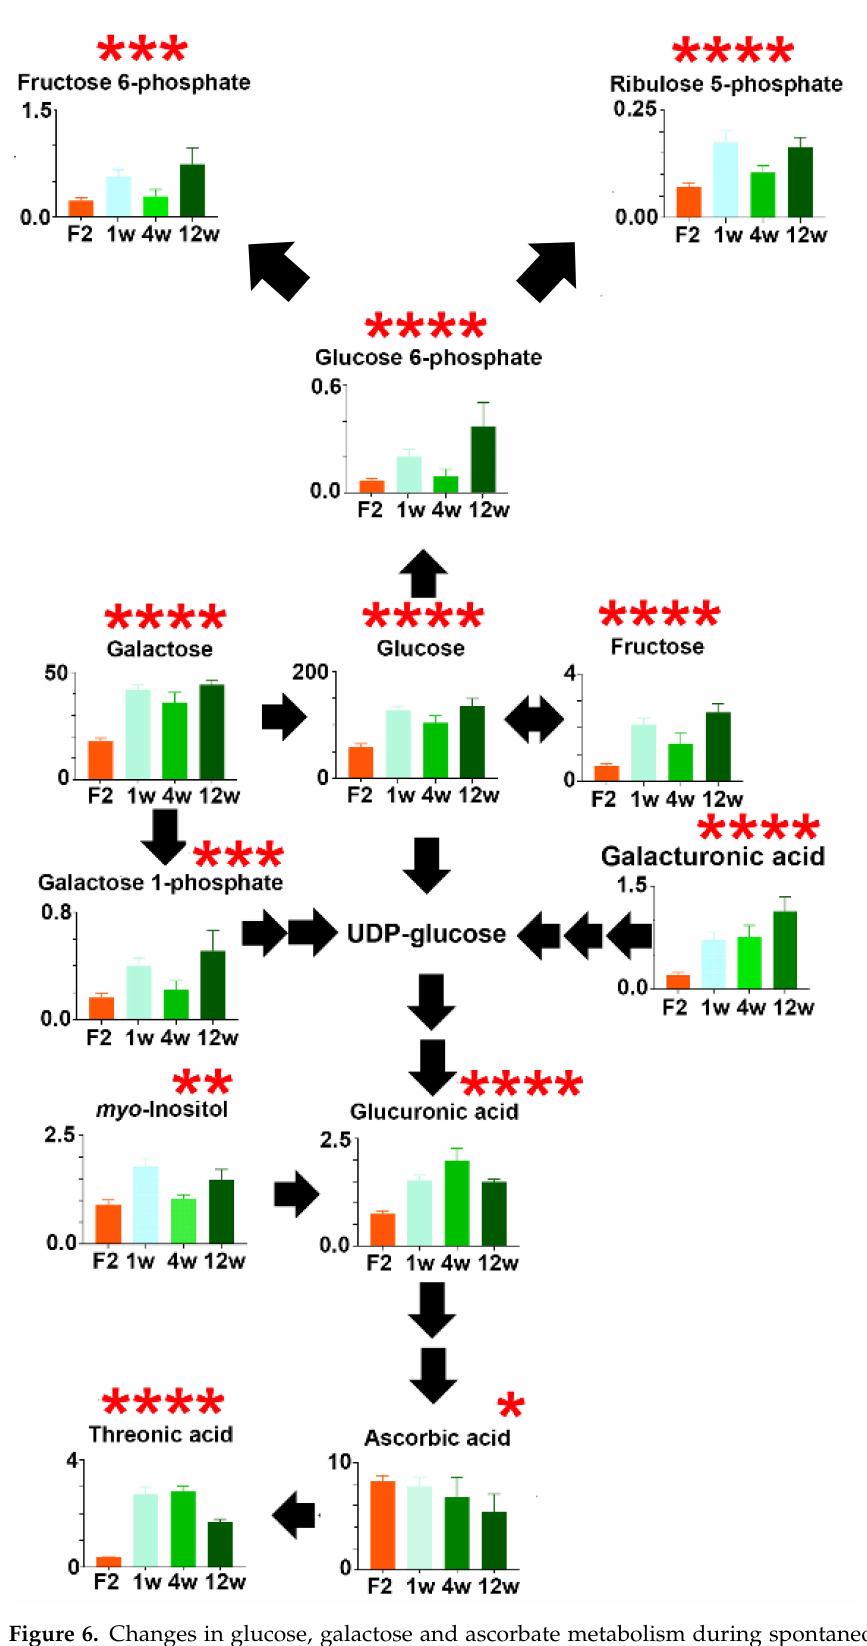
Figure 6. Changes in glucose, galactose and ascorbate metabolism during spontaneous recovery of HF-CDAA-induced liver fibrosis (F2) over 1–12 week * = p < 0.05; ** = p < 0.01; *** = p < 0.001; **** = p <